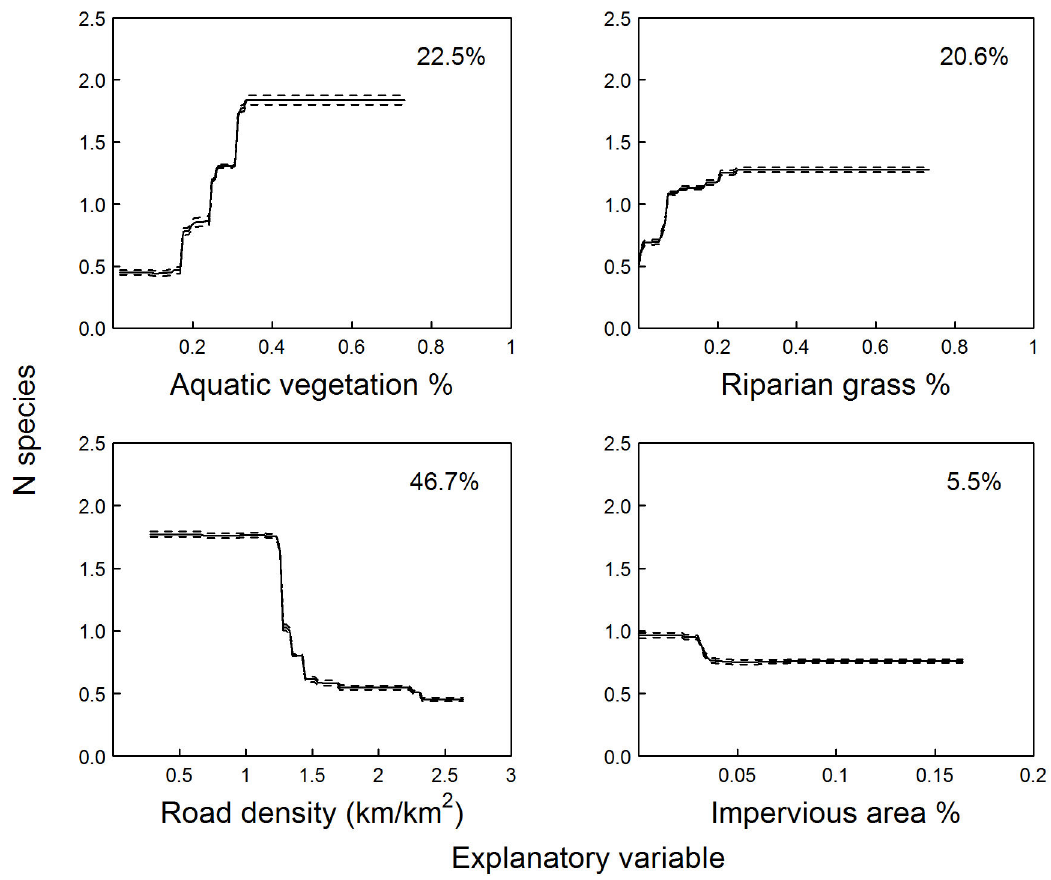
Figure 2. Marginal effect plots of the three main explanatory variables (deviance explained >5%). Plots represent the effect of each variable on species richness (top) and probability of occupancy for C. signifera (centre) and L. dumerilii (bottom) while controlling for the average effect of all other variables in the model. Road density values log-transformed. Dashed lines represent 95% confidence intervals calculated over 1,000 iterations of the model fitting